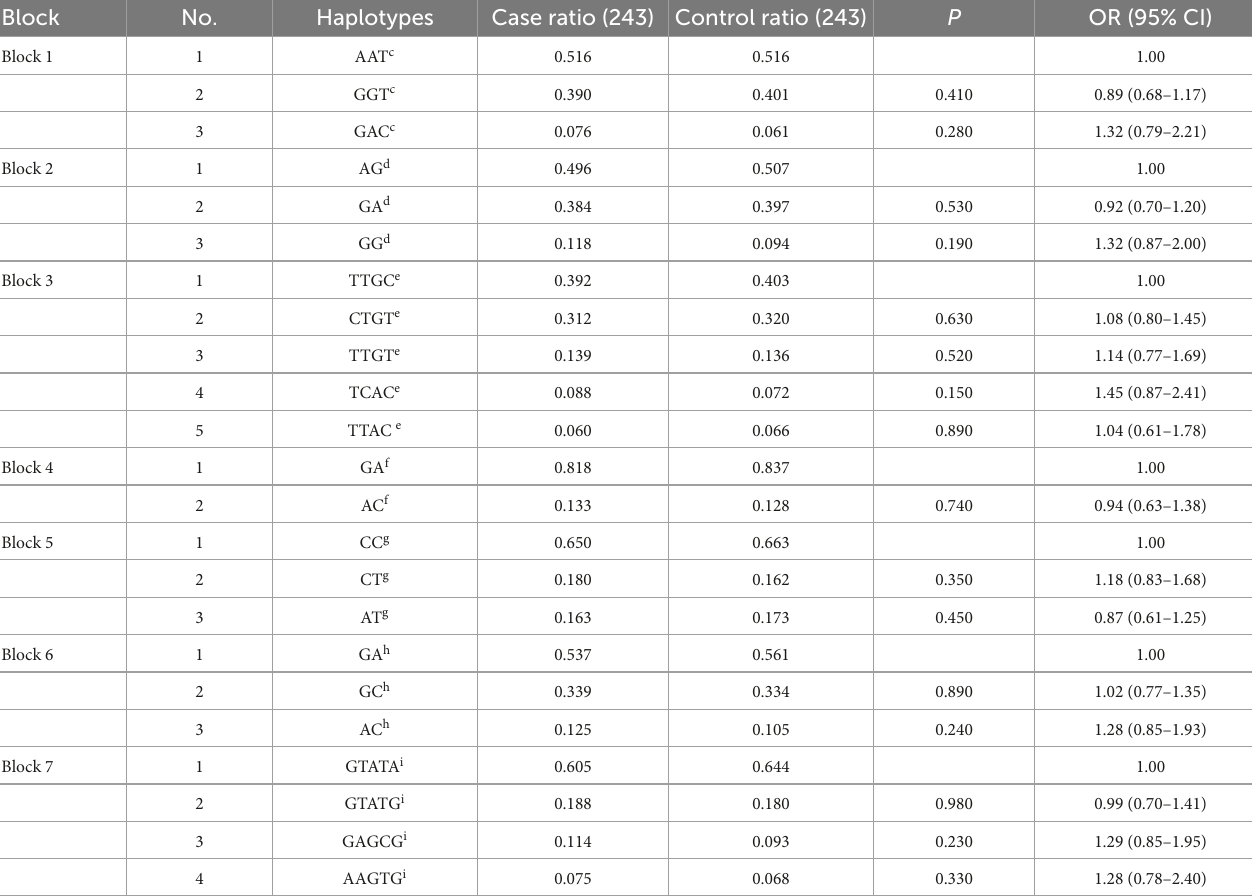
TABLE 6 Distribution of KCNB1 haplotypes in cases and controls adjusted by age and sex (frequency more than 5). Block